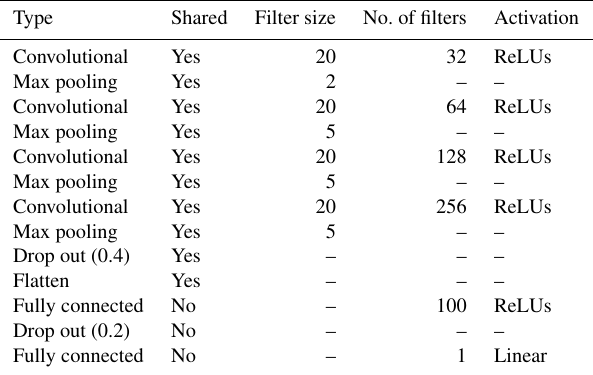
ReLUs – rectified linear